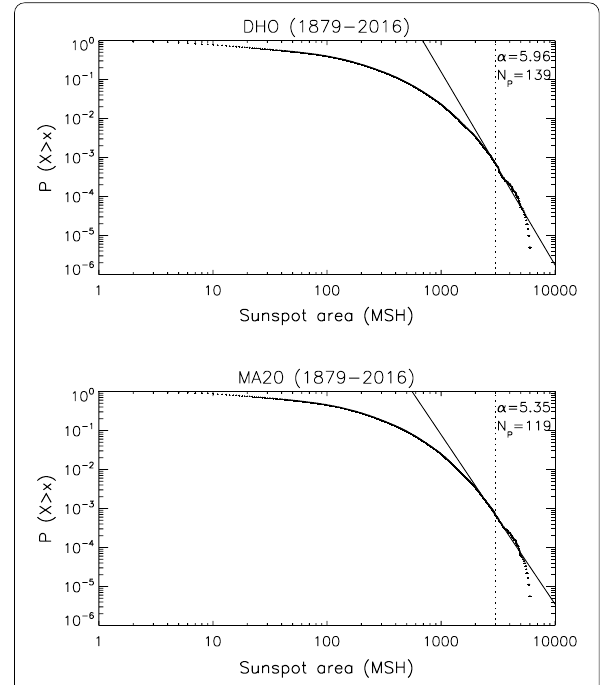
Fig. 5 Complementary cumulative distribution of occurrence number as a function of sunspot area in the DHO (upper panel) and MA20 (lower panel) catalogues. N P is the total data number for sunspot area ≥ 3000